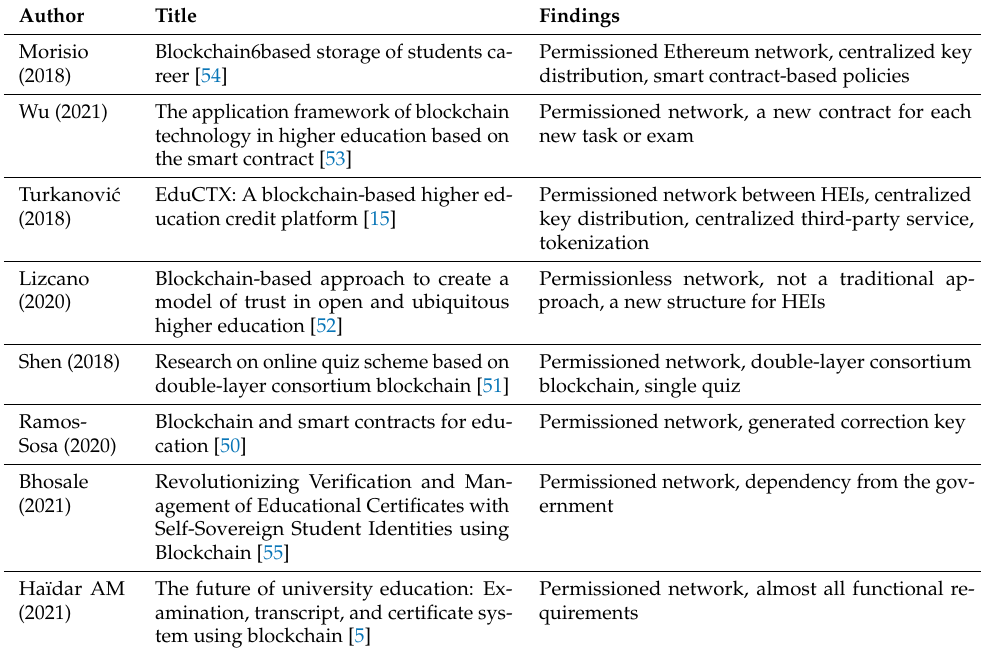
Table 3. Student assessments and exams summary